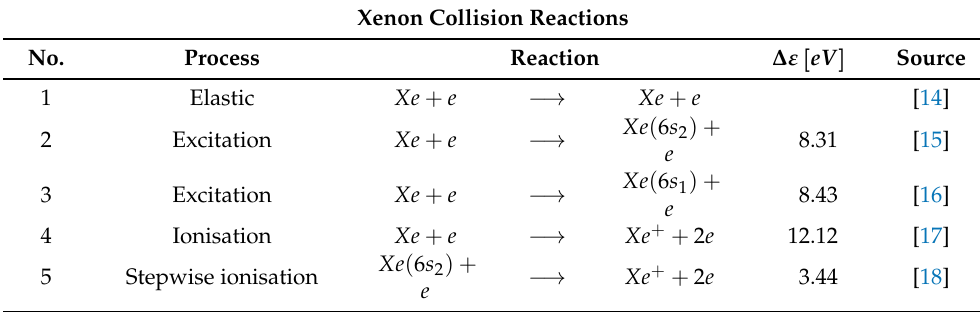
Table 1. Overview of the reactions and data sources used for the simulation.